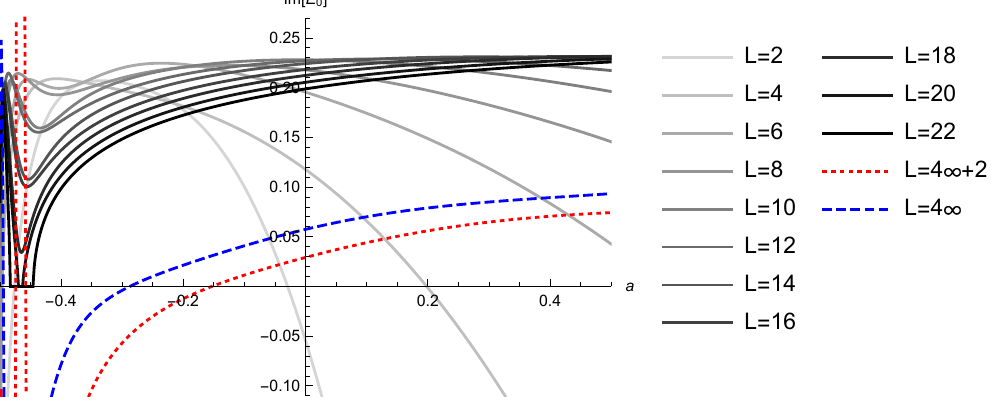
Figure 6 . Plots of the imaginary part of the gauge invariant observable E 0 (2.17) for the “double brane” solution Φ D at the truncation level L . The dotted and dashed lines are extrapolations to a L = 4 k + 2 ( k → ∞ ) and L = 4 k ( k → ∞ ), respectively. The horizontal axis denotes the value of the parameter a